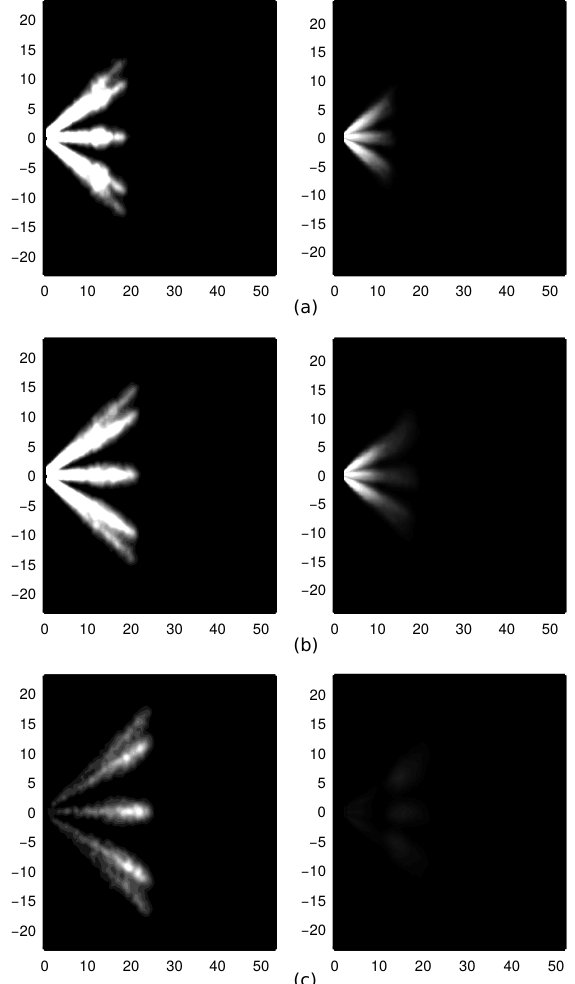
Figure 9. Numerical ( left ) vs. UoM experimental ( right ) PLV maps for the baseline condition (G1). ( a ) at 0.3ms, ( b ) at 0.6ms and ( c ) at 0.9ms after SOI. Liquid volume fraction range is 0–0.01mm 3 /mm 2